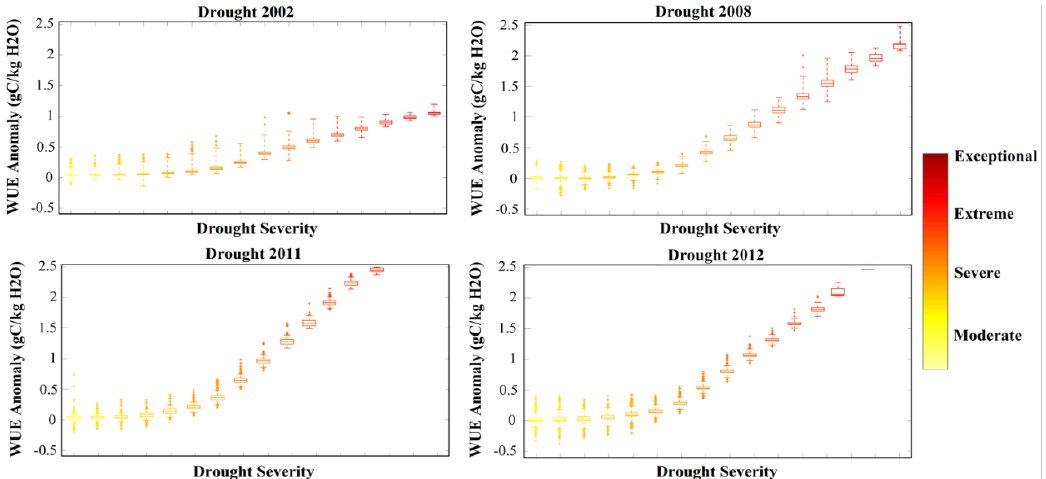
Figure 8. The distribution of relative anomaly of evapotranspiration (ET), GPP and WUE for the 2002, Figure 7. The distribution of WUE anomaly in response to varied drought severities for the 2002, 2008, 2008, 2011 and 2012 drought episodes. In each plot, the blue curves on the axes show the distribution 2011 and 2012 drought episodes. of the corresponding variable. Remote Sens. 2019 , 11 , x FOR PEER REVIEW